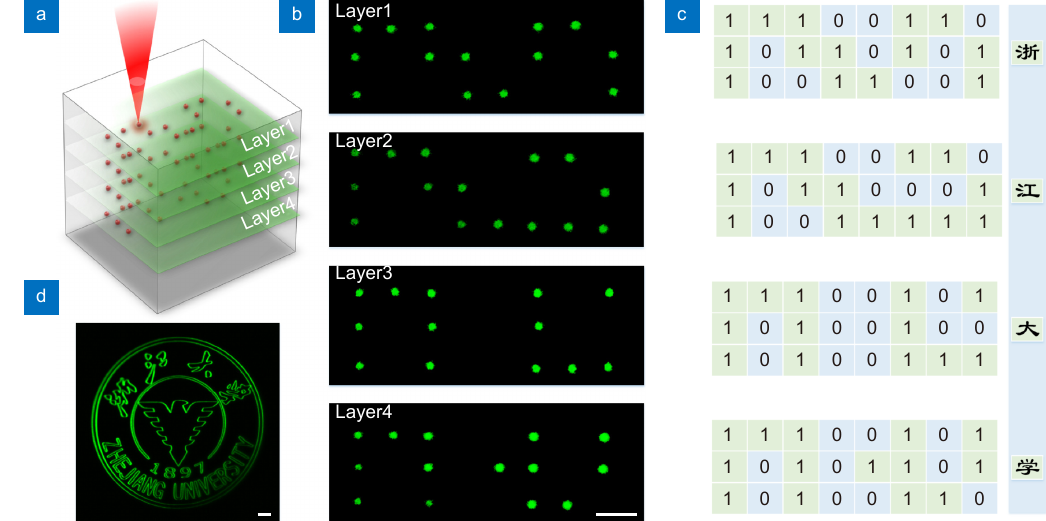
Fig. 3 | Optical information writing and readout. ( a ) Schematic diagram of 3D information writing in the glass. ( b ) Recorded information in glass in different layers. Dots in layer 1 and layer 2 are written by single pulse with 200 nJ. Dots in layer 3 and layer 4 are written by single pulse with 250 nJ and 300 nJ, respectively. Scale bar: 10 μm. ( c ) Encode information by binary format. ( d ) Complicated logo pattern recorded in the glass. Scale bar: 20